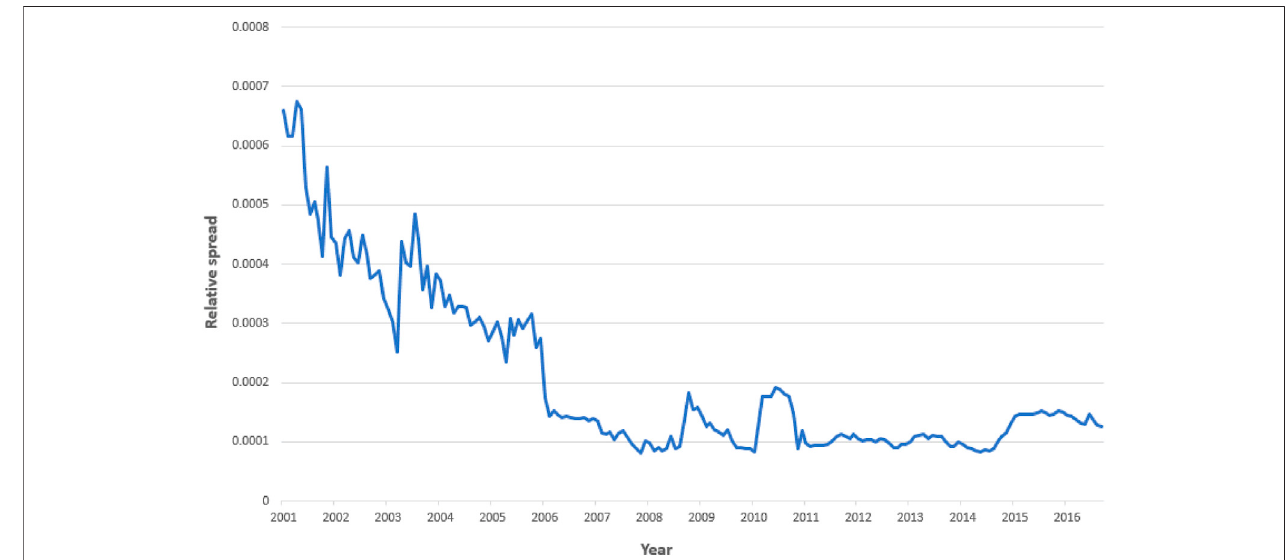
FIGURE 2 | Monthly relative spread of US